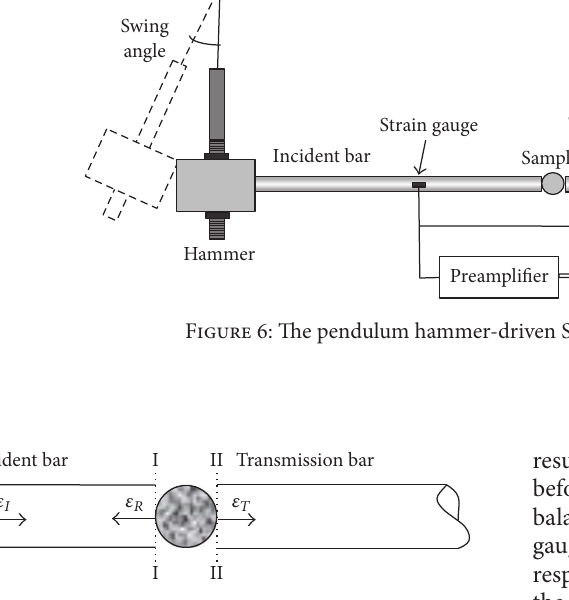
Figure 7: Wave propagation between bar and specimen